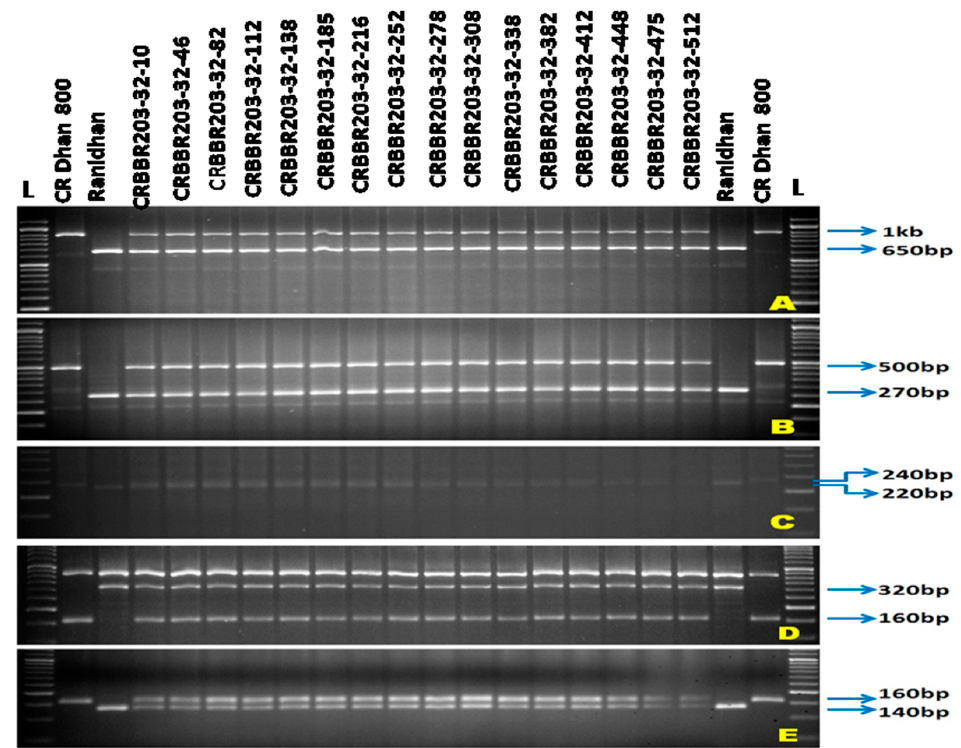
Figure 4. Electropherogram of BC 3 F 1 derivatives of rice variety, Ranidhan for four BB resistance genes Xa21, xa13 , xa5 and Xa4 using markers ( A ) pTA248 for Xa21 ; ( B ) Xa-13 prom for xa13 ; ( C ) RM122 & ( D ) xa5S/R (Multiplex) for xa5 ; ( E ) MP-Nbp-131 for Xa4 . Lane 1, 22: 50 bp ladder; Lane 2, 21: CR Dhan 800; Lane 3, 20: Ranidhan; Lane 4–19: BC3F 1 derivatives of rice variety,